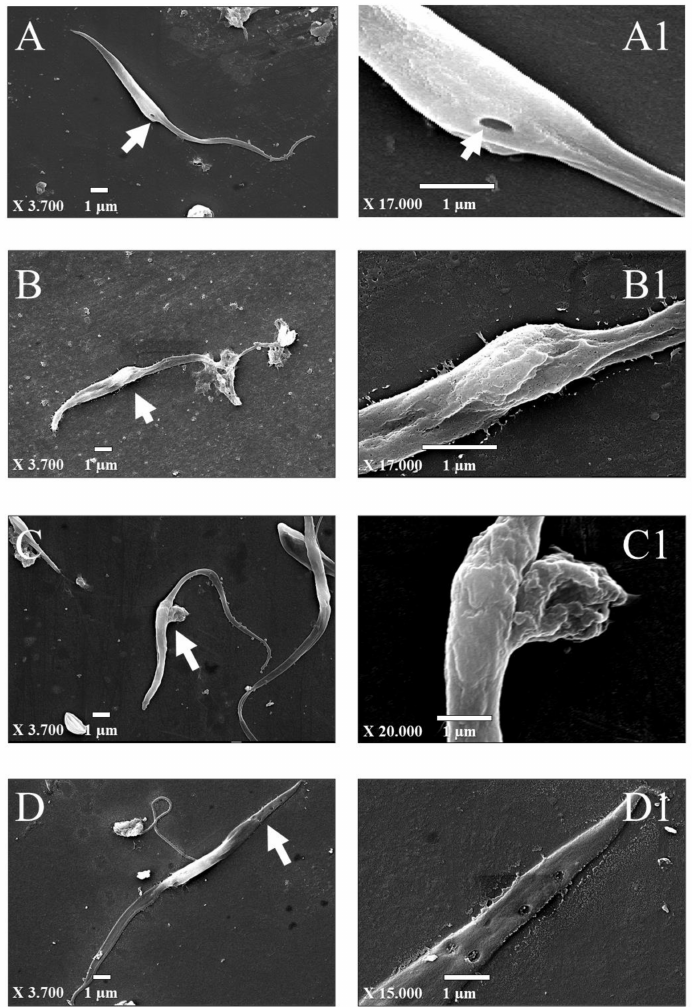
Figure 6. Morphological alterations in T. cruzi after compound treatment analyzed by SEM. Epimastigotes treated with Benznidazole at 7.91 µ M (BZ); N, N’ -Squaramide 17 at 6.56 µ M (S) and Mimetic lipid membranes containing N, N’ -Squaramide 17 at 7.93 µ M (MLS) for 72 h. ( A , A1 ) Control (without treatment); ( B , B1 ) BZ; ( C , C1 ) S; and ( D , D1 ) MLS. Arrows indicate highlighted changes magnified on the right